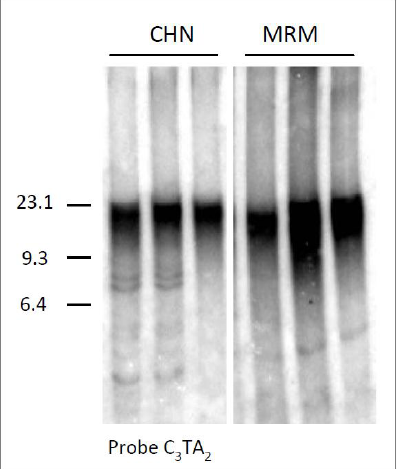
TA ) . M,  Hind III size marker (in kb). 3 2 3